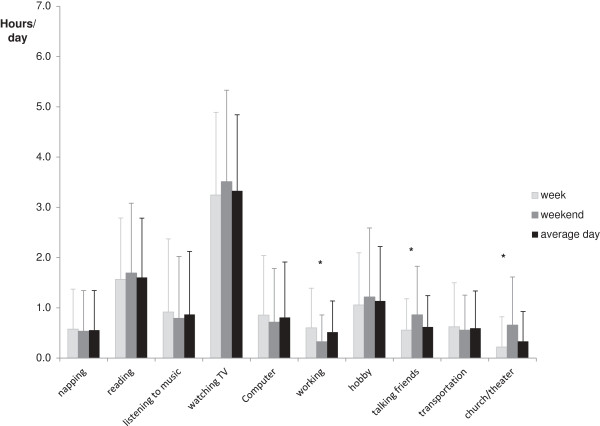
The mean self-reported time (h/d, with standard deviation) spent on 10 sedentary activities for weekdays, weekend days and an average day. *P < 0.05 week versus weekend day.